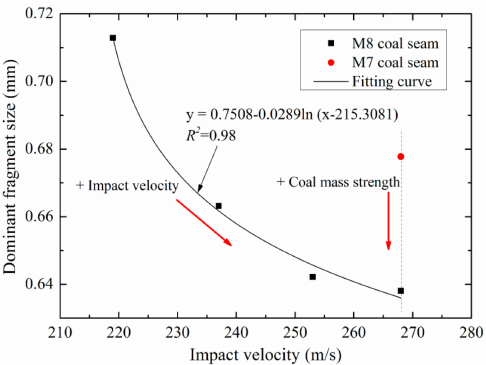
Figure 9. Relationship between the dominant fragment size and the jet impact